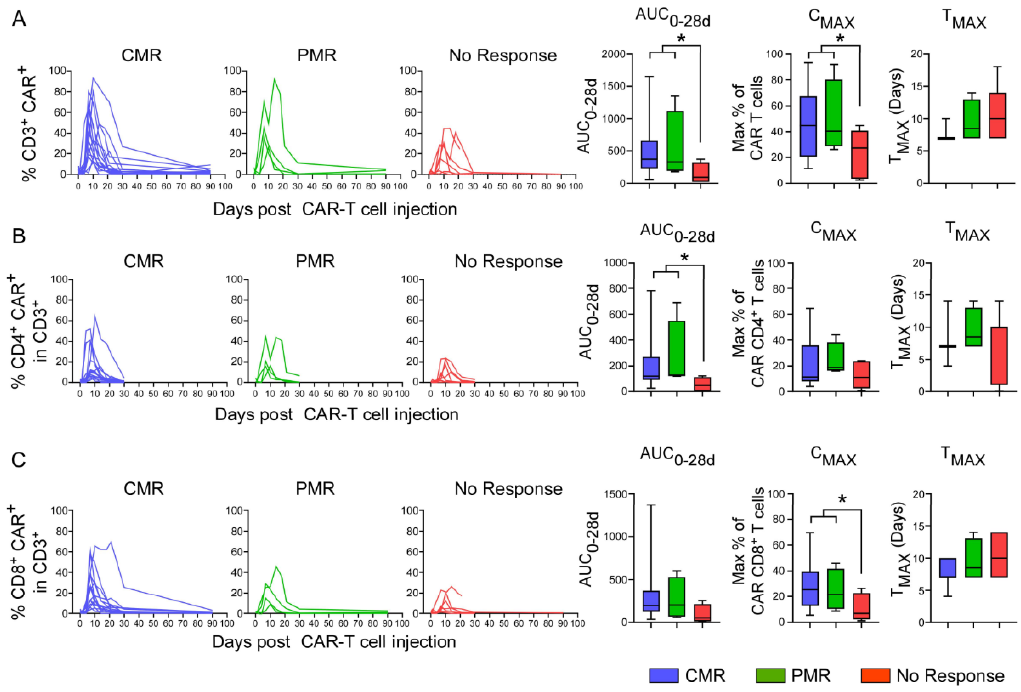
Figure 4. In vivo pharmacokinetics of CAR + T-cells following infusion. ( A ) The percentages of CAR + T-cells within the peripheral CD3 + lymphocyte pool were monitored in 27 patients by flow cytometry at the indicated time points following infusion and are presented as a function of their clinical response; CMR, PMR, and no response (left). Area under the curve (AUC 0-28 ), representing the area under the curve of the percentages of CAR + T-cells from day 0 to day 28 post-CAR + T infusion; maximal concentration post-infusion (C MAX ); and time to maximal concentration (T MAX ), and their median, IQR, and range (n:27), are presented. ( B ) The percentages of CD4 + CAR + cells within the total peripheral CD3 + T-cell population are presented as in panel A, as well as AUC 0-28 , C MAX , and T MAX are presented. ( C ) Evaluations are presented as a function of CAR + CD8 + T-cells. Note that patients with incomplete kinetics were not included in the AUC evaluation. p -values were calculated using a Mann–Whitney test and significant values are shown (*: p <